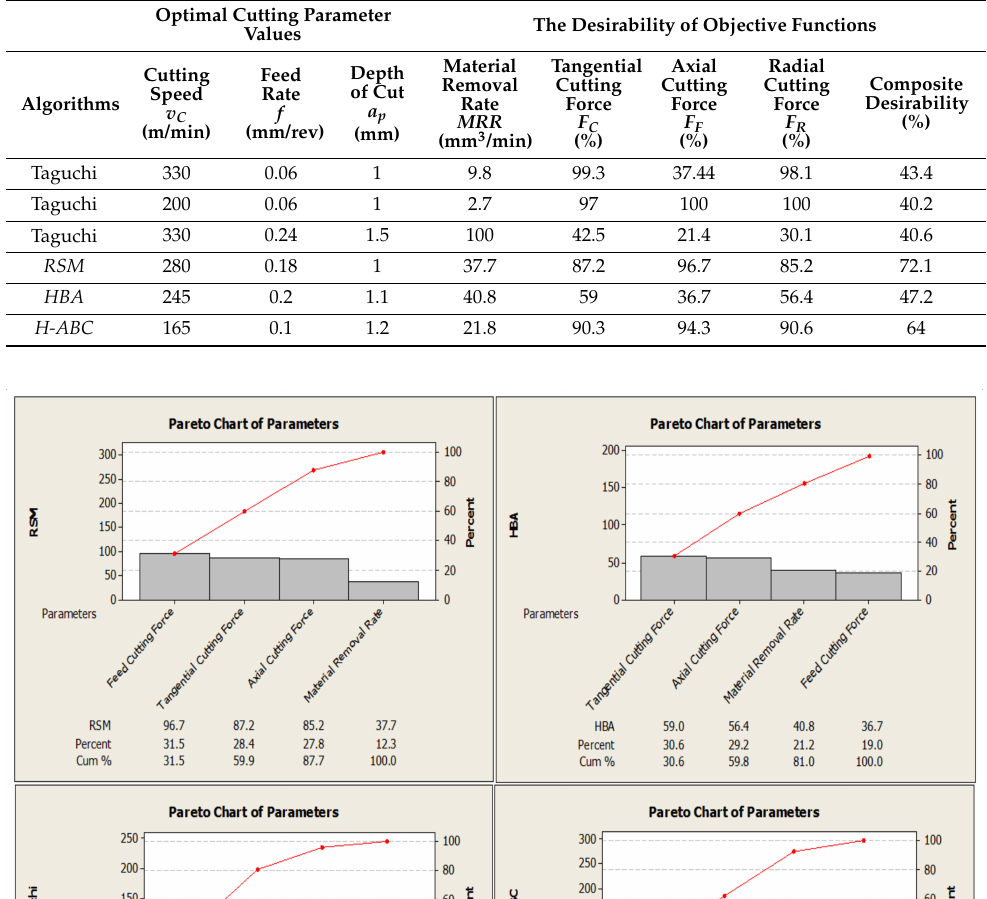
Table 7. The optimization results for all of the methods.